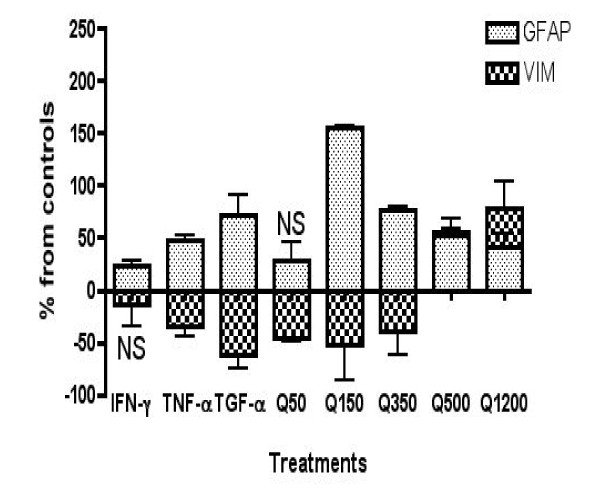
Quantification of GFAP and vimentin using ELISA after 24 hours stimulation with IFN-γ, TNF-α, TGF-α and QUIN. GFAP and VIM indirect ELISA have been done in triplicates. All samples except IFN-γ stimulated VIM protein expression and 50 nM QUIN stimulated GFAP expression were statistically significant (p < 0.05).